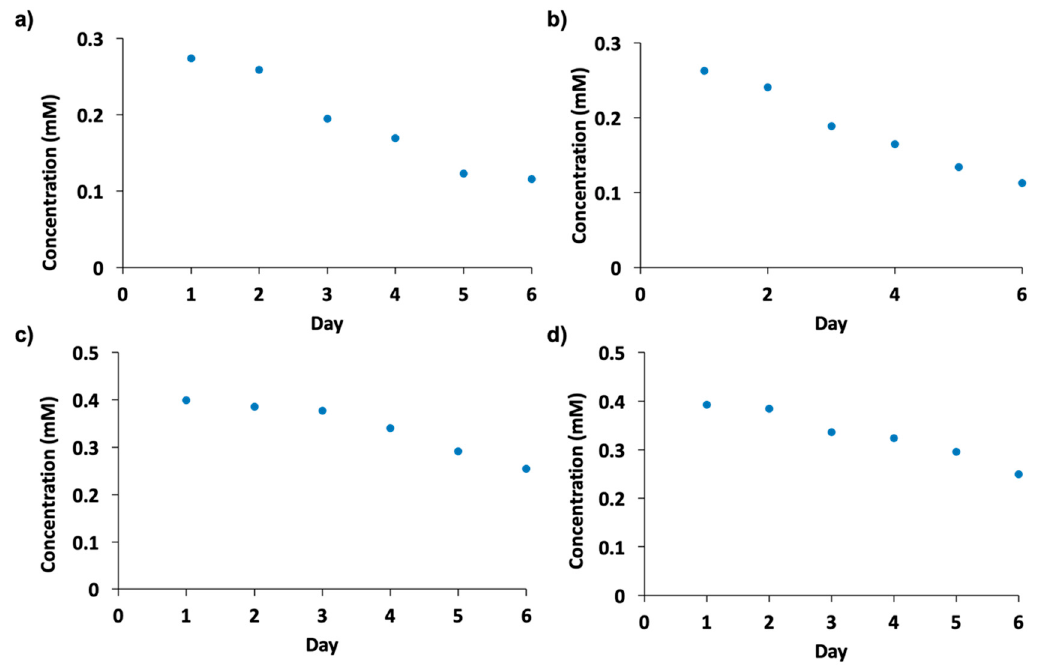
Figure 6. Recycling experiments with both enzymes entrapped in L and D amino acid hydrogels. a ) MA- L -Phe-OH hydrogel with an HRP enzyme entrapped. Fresh substrate solution was placed on top of the gel each day and product was quantified at absorbance 420 nm. b ) MA- D -Phe-OH hydrogel